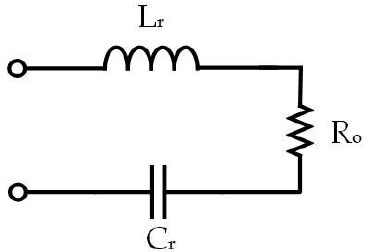
Figure 11. RLC series resonant circuit.